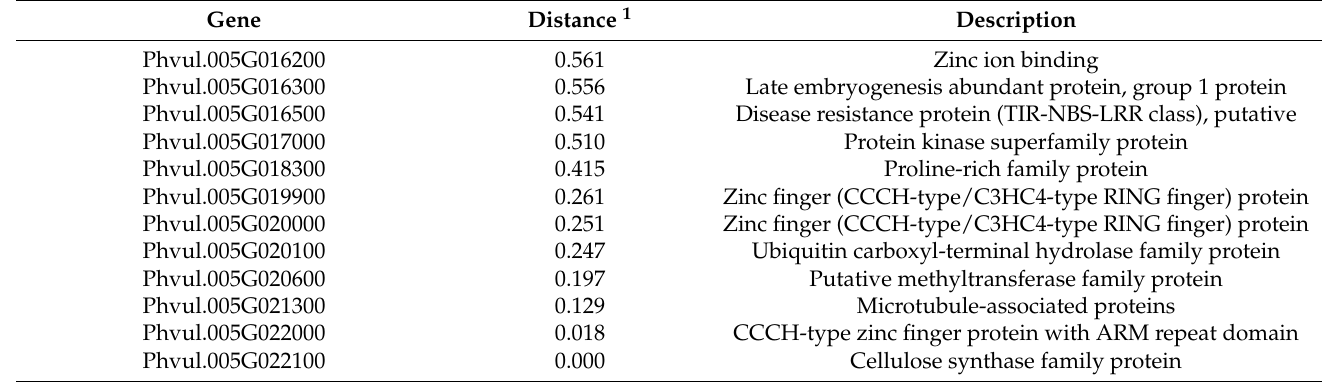
Table 5. Annotation of candidate genes with a confidence interval (0.694 Mb) of each significant SNP ss715646169 associated with the Fusarium wilt ( Fop ) strain IAC18001 for DSR ( p -value 2.20 × 10 − 5 ) and AUDPC ( p -value 2.42 × 10 − 5 ) for 205 common bean genotypes and 2001 SNPs: SNP’s positions in mega base pairs (Mb).